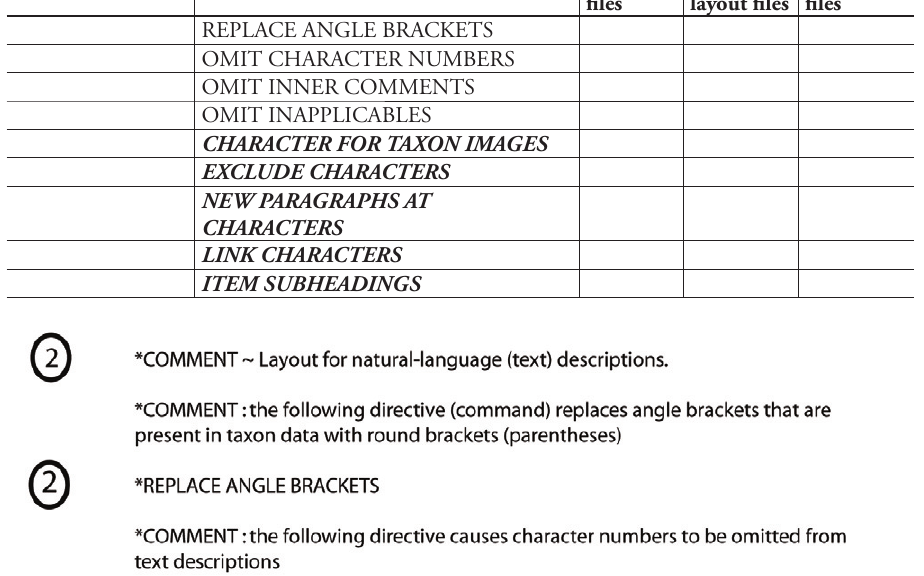
Figure 33. Th e layout directive fi le contains the formatting commands for producing natural language descriptions. Th e numbers to the left of the directive fi le indicate diff erent classes of directives (see Table 6). Th e grey ovals show commands where input of the user might be required. (continued on next page).